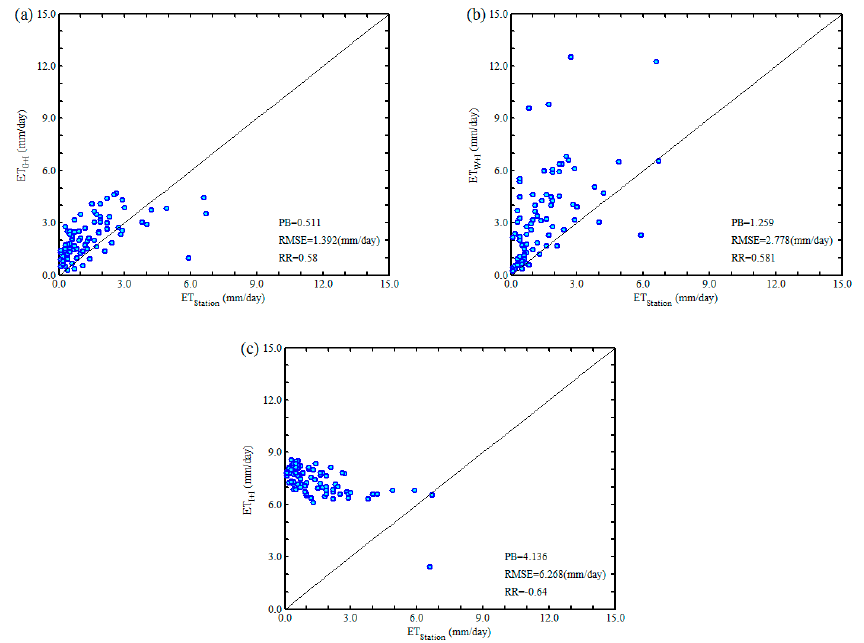
Figure 8. Comparison of daily-scale ( a ) G + I, ( b ) W + I and ( c ) I + I simulated ET with pan evaporation at HYK Station.